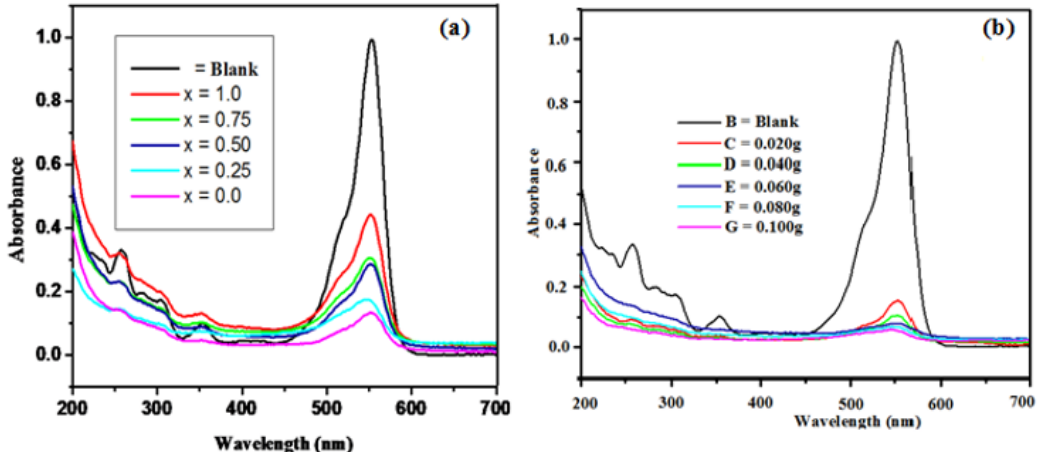
Ni AlCrO (0 ≤ x ≤ 1); (b) Photocatalytic degradation of Rhodamine 1-x x 4